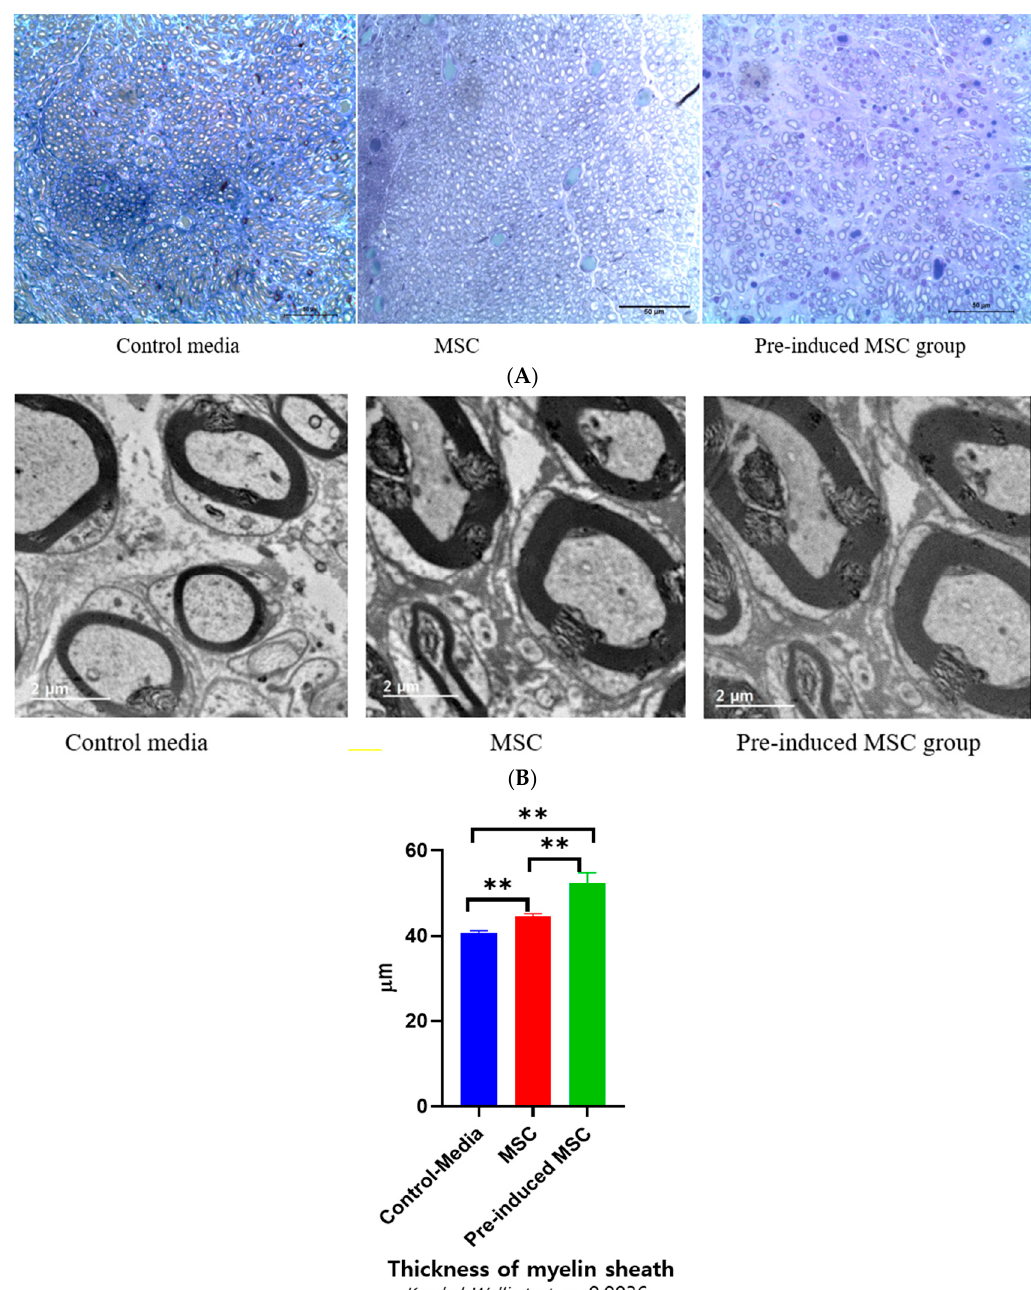
Figure 7. Pre-induced MSC showed better regeneration than other groups. Values of ** p < 0.01, *** p < 0.001, and **** p < 0.0001 were considered statistically significant.